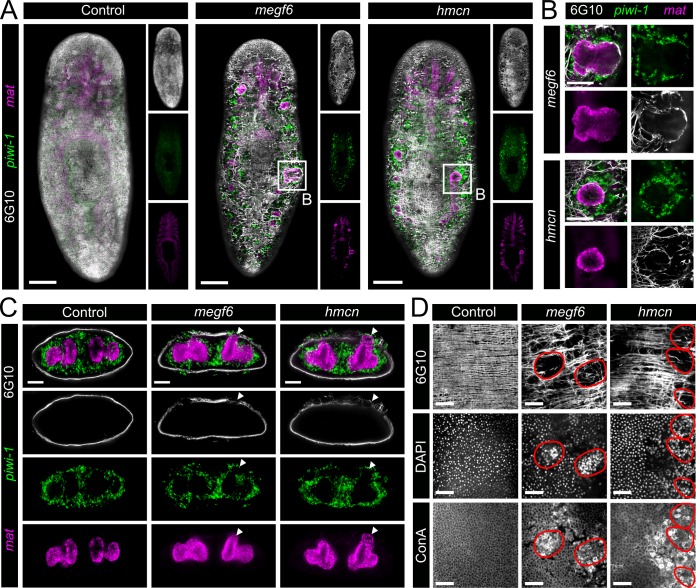
Muscle lesions and ectopic gut branches associated with ectopic neoblasts.A) Double FISH for piwi-1 and mat combined with 6G10 antibody to mark muscle fibers (n ≥ 10). Single confocal planes at the dorsal sub-epidermis of whole control, megf6, or hemicentin knockdown planarians show the dorsal layers of body wall muscle. White boxes denote the magnified regions in B). B) High magnification of ectopic mat+ cells from the megf6 or hemicentin knockdown animals in A. piwi-1 and 6G10 stains are also shown. C) Transverse cross-sections of control, megf6, or hemicentin knockdown worms stained with double FISH for piwi-1 and mat and 6G10 antibody. White arrowheads show ectopic mat+ structures (n ≥ 3). D) 6G10, DAPI, and Concanavalin A (ConA) staining in the same region of control and knockdown planarians (n ≥ 5). DAPI and ConA tiles are the same confocal plane at the epidermis, while 6G10 tiles are extended focus images from the epidermis to the muscle layer directly below. Red circles denote the regions with severe muscle lesions. Scale bars: 250 μm in A; 100 μm in B, C; 50 μm in D.